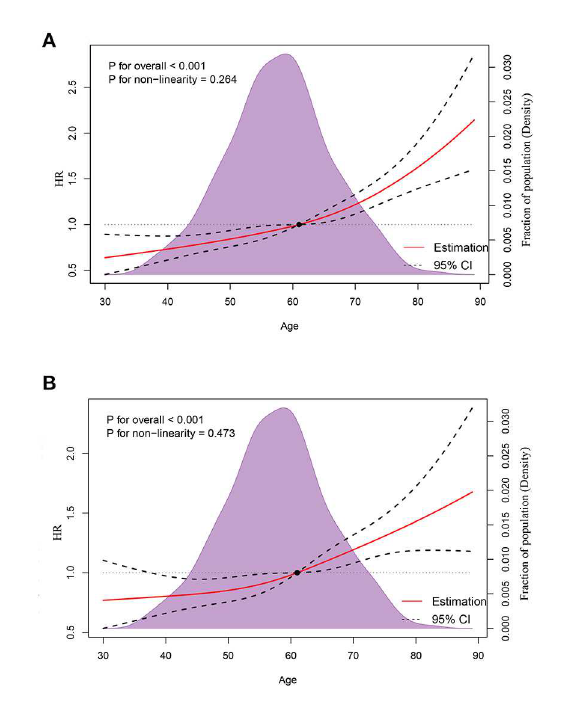
FIGURE3 Association between age and all-cause mortality (A) and cancer-specific mortality (B) using restricted cubic spline regression models.